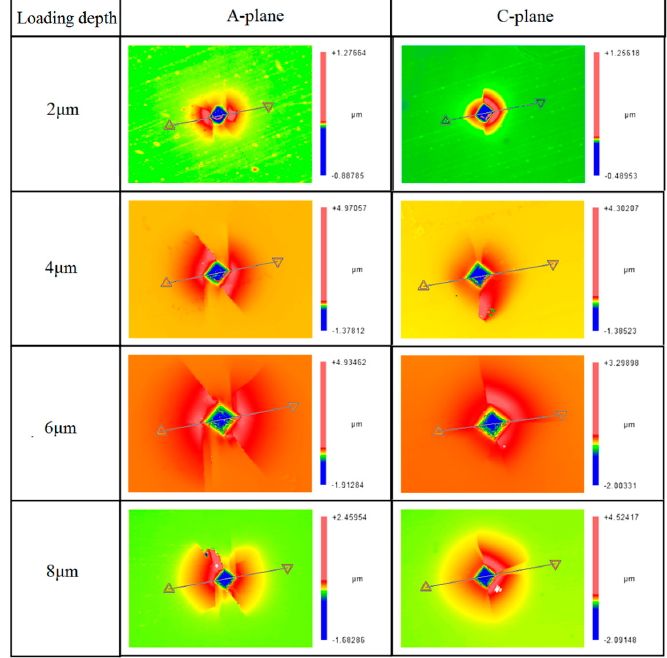
Figure 11. 3D morphology of A-plane and C-plane sapphire tested by sequential indentation after unloading measured by three-dimensional (3D) profile.